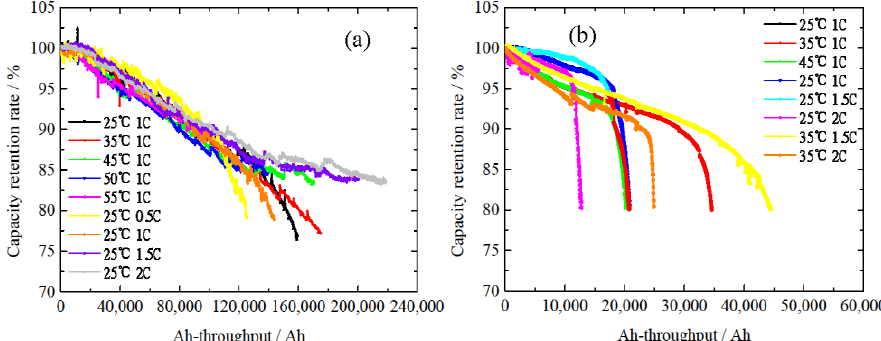
Figure 1. ( a ) Capacity degradation of Battery Ⅰ ; ( b ) capacity degradation of Battery Ⅱ